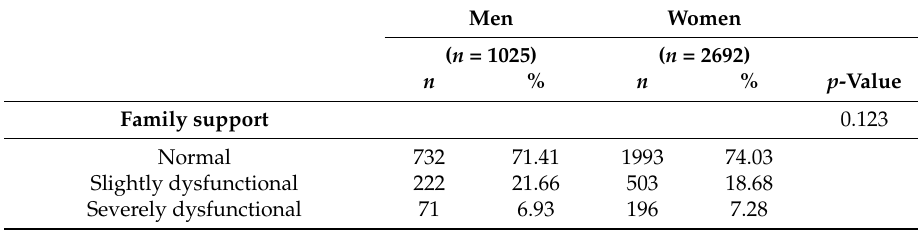
Table 1. General characteristics of the study population and differences by gender. UniHcos project 2016.